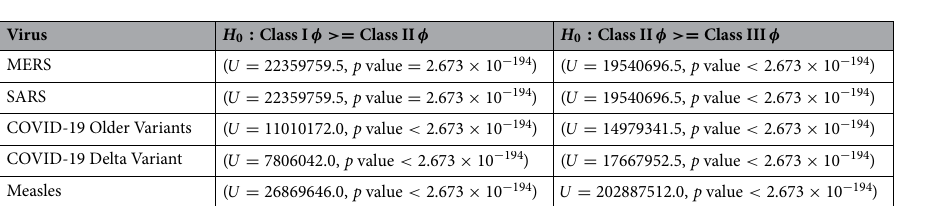
Table 2. Results from Mann-Whitney U tests for the null hypotheses H 0 : Class I φ > = Class II φ and